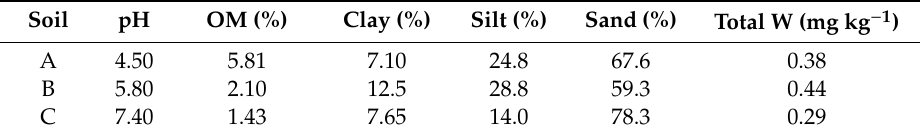
Table 1. Characteristics of the soils A, B, and